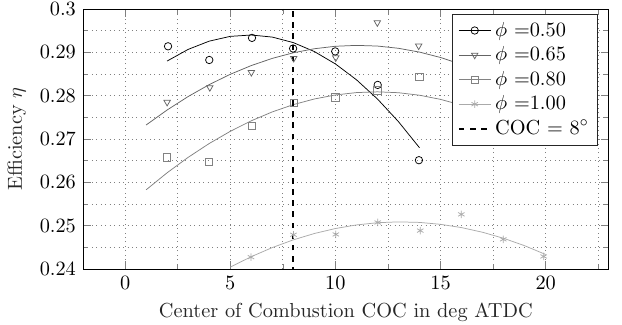
Figure A2. Measured engine efficiency as a function of the center of combustion COC for various fuel-to-air equivalence ratios φ at load p me = 3.19 bar and speed 1400